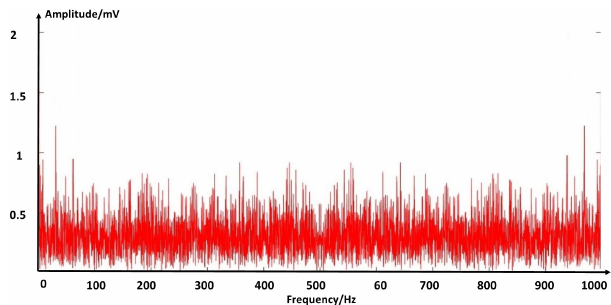
Figure 11. Spectrogram of the EIN in the 0–1kHz band.